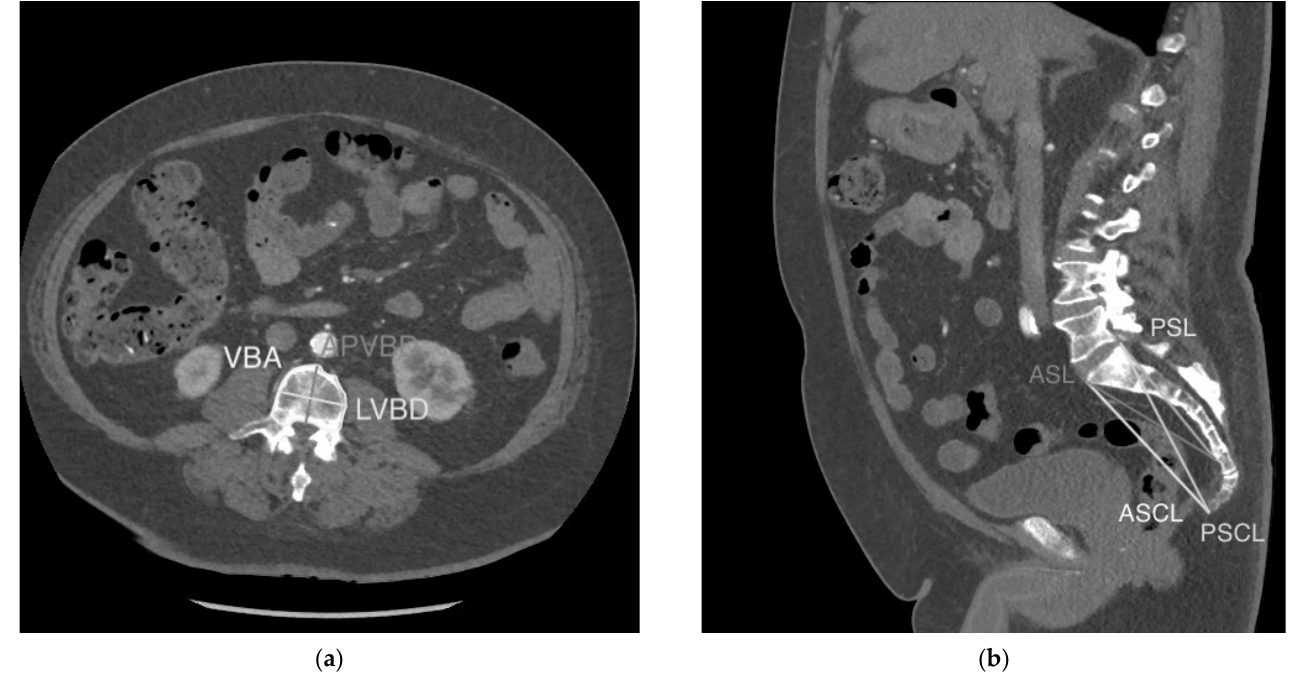
Figure 1. Vertebral measurements. ( a ). VBA, LVBD and APVBD displayed on an axial section through the superior endplate of L3. ( b ). ASL, PSL, ASCL and PSCL displayed on a mid-sagittal section through the abdomen/pelvis. The measured vertebral parameters were then used to calculate heights in this cohort based on various formulae available in the literature for each sex (Tables 1 and 2) [9–13]. Calculated heights were recorded to the nearest decimal of a centimetre (cm). Table 1. Regression equations used to generate height estimates for female participants.